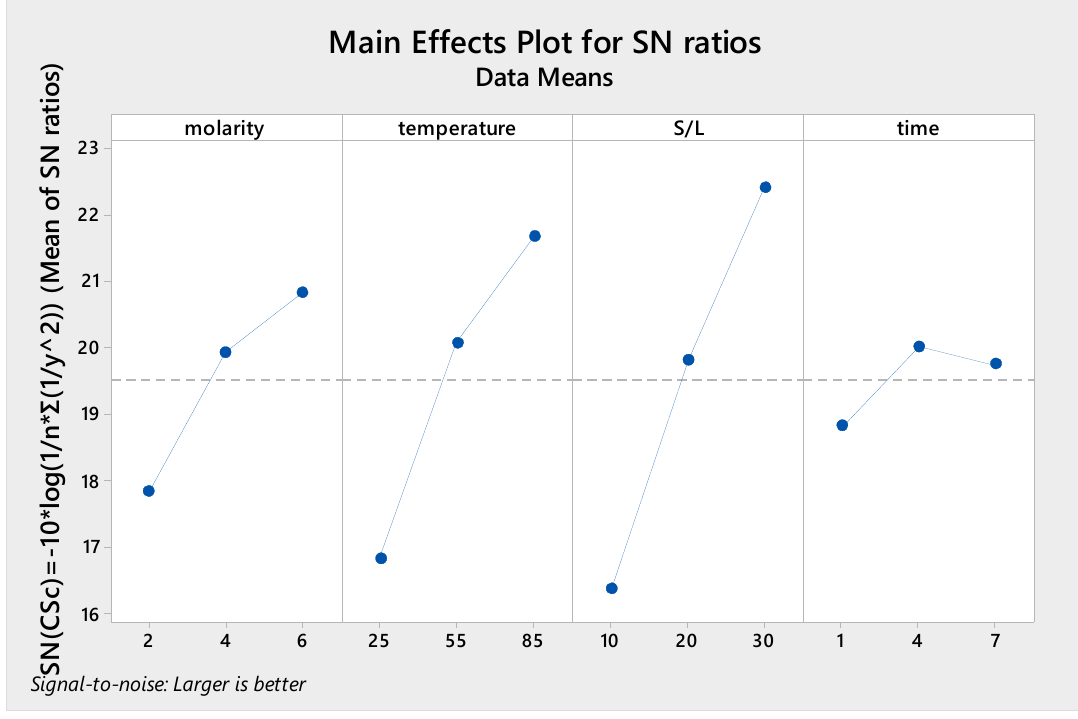
Figure 2. Effects of each parameter (( A ) Acid molarity, ( B ) Temperature, ( C ) Solid-to-Liquid ratio (S/L), and ( D ) Leaching time) associated with their levels on the statistical performance of S/N ratio for Sc.